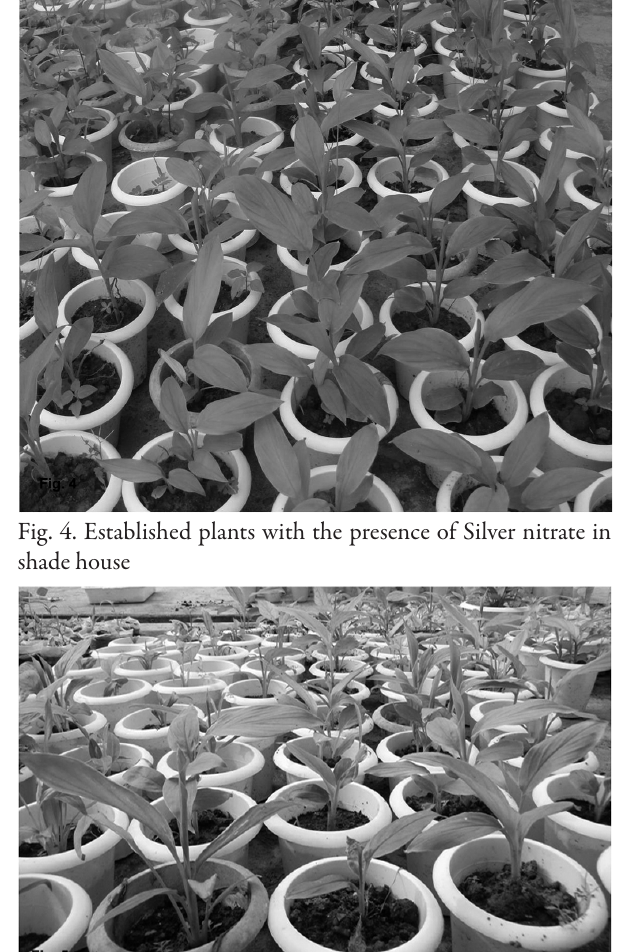
treatment during acclimati- 3